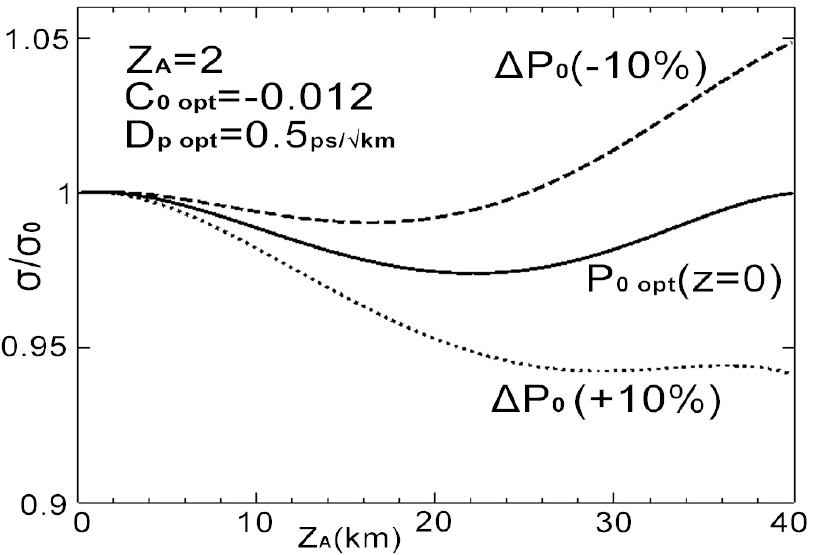
Figure 7. Evolution of the normalized widening with z A = 2 in an amplification stage with different initial power peaks: optimal power ( — ), 10% over ( · · · ) and 10% under( − − − ), in all the three cases shared between components according to (55) and (56) with θ = π /4 and optimal chirp. The value for the PMD parameter is D p = 0.5 ps · km − 1/2